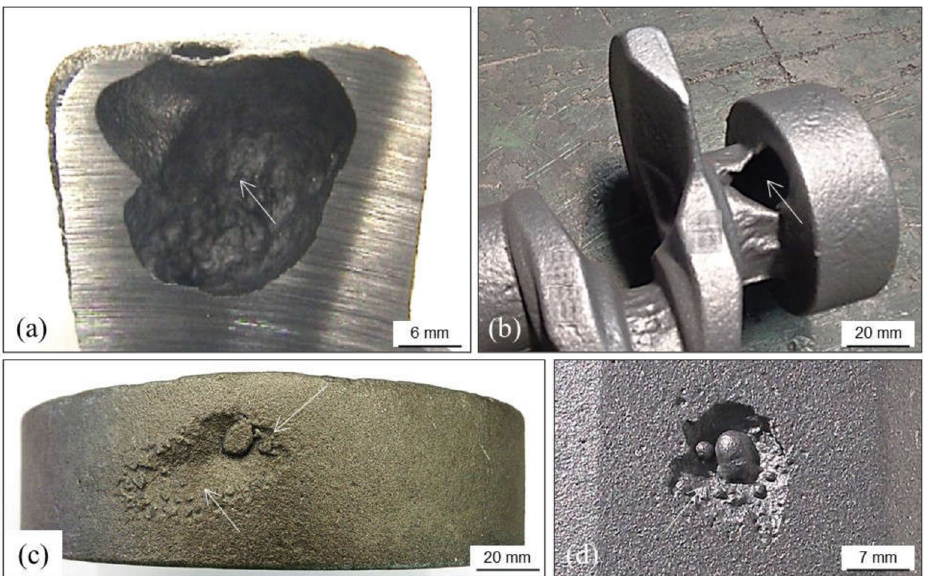
Figure 70. Primary shrinkage defects found in ( a ) grey iron riser; ( b ) a ductile iron crankshaft manufactured without any inoculant addition (low graphite expansion); ( c , d ) two grey iron castings with wall shrinkage as depressions containing phosphide